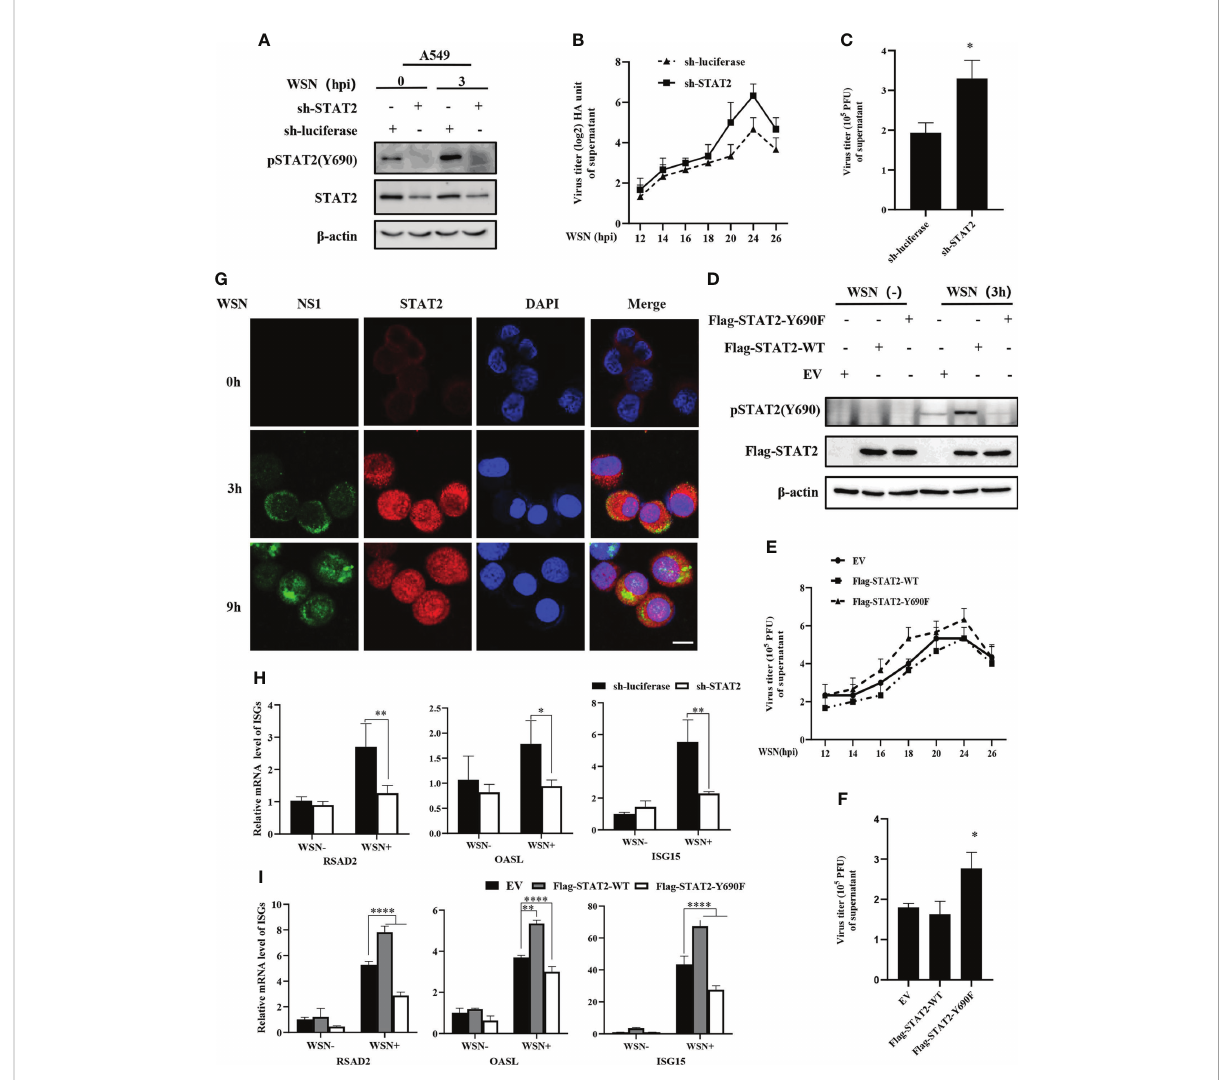
FIGURE 4 Disruption of STAT2 phosphorylation at Tyr690 promotes the IAV replication. (A) A549 cells stably expressing speci fi c sh-RNA targeting STAT2 and control (luciferase) were infected with WSN virus for 3 (H) Cell lysates were analyzed by Western blotting with indicated antibodies. (B, C) STAT2- and luciferase- ablated A549 cells were infected with WSN (MOI = 1). Viral titers in supernatant of these cell cultures were examined by hemagglutinin (HA) assay at the indicated time points post infection (B) . Sh-RNAs knockdown A549 cells or control cells were infected with WSN as described in (B) . Viral titers in the supernatants of these cells were examined by plaque assay (24 h) (C) . The mean ± SD of three independent experiments is given. (*P < 0.05) (D) A549 cells stably expressing STAT2-WT, STAT2-Y690F, and empty vector (EV) control were infected with or without WSN for 3 h and examined by Western blotting with the indicated antibodies. (E) A549 cells stably expressing STAT2- WT, STAT2-Y690F, and empty vector (EV) control were infected with WSN for indicated time point. Hemagglutinin (HA) assay were performed to examine the viral titers in the supernatant of cell culture. (F) The STAT2 overexpressing A549 cells or control cells as described in (D) were infected with WSN. Viral titers in the supernatant of these cells culture were examined by plaque assay (24 h). Data are represented as mean ± SD. (*P < 0.05.) (G) A549 cells were infected with or without WSN virus for 0 h, 3 h, and 9 (h) Immuno fl uorescence staining was performed to detect STAT2 (red) and NS1 (green). The nuclei were stained with DAPI (blue). Scale bar, 10 m m. (H) RT-qPCR was performed to detect the expression of RSAD2, OASL, and ISG15 in STAT2 knockdown A549 cells with IAV infection for 3 (h) (I) STAT2 overexpressing or control A549 cells as described in (D) were infected with WSN for 3 h, and the expression of RSAD2, OASL, and ISG15 was detected by RT-qPCR. Error bars represent the mean ± SD from three independent experiments. *p < 0.05; **p <0.01; ****p